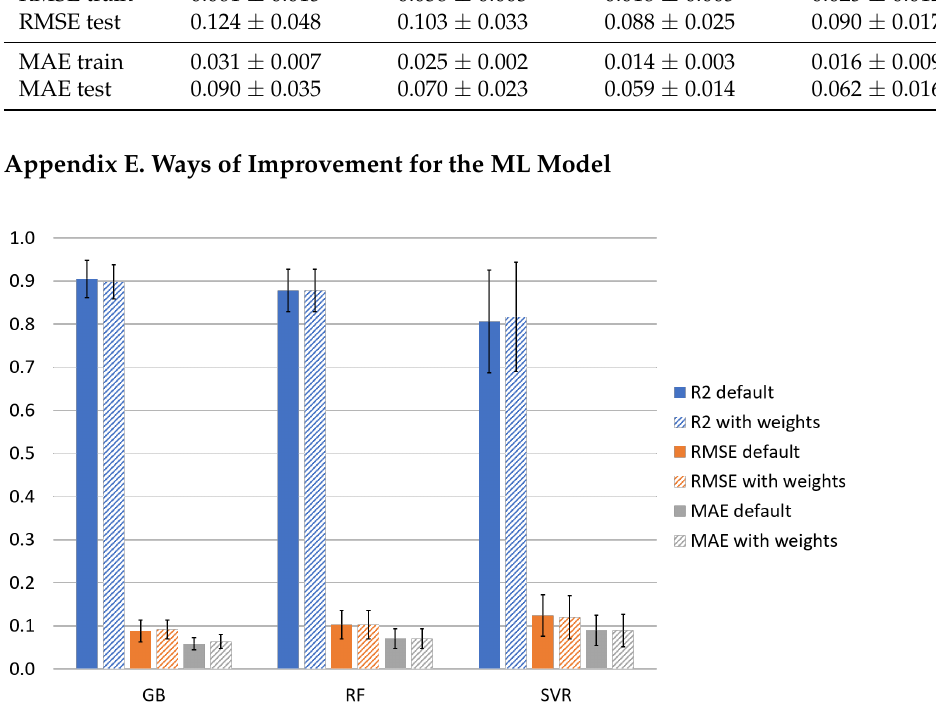
Figure E1. Comparison of test performances of GB, RF and SVR with optimized HPs, without weighted vs. with weighted